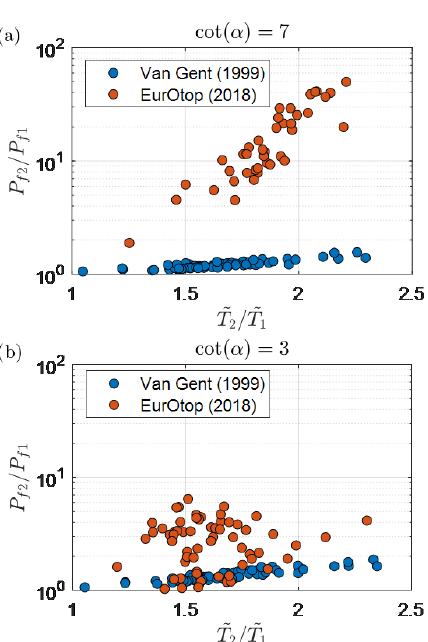
Figure 14. Relationship between the change in probability of fail- /P f ure due to IG waves ( P f ) and the increase in the relative spec- 2 1 tral wave period at the toe ( ˜ T 2 / ˜ T 1 ) calculated using the original Van Gent (1999) and EurOtop (2018) approaches for the actual overtopping discharge for (a) cot (α) = 7 and (b) cot (α) = 3. Note that cases with wave steepness at the toe < 0.01 were excluded from the EurOtop (2018) calculations, since the equivalent slope concept could not be applied (Sect. 4.2).